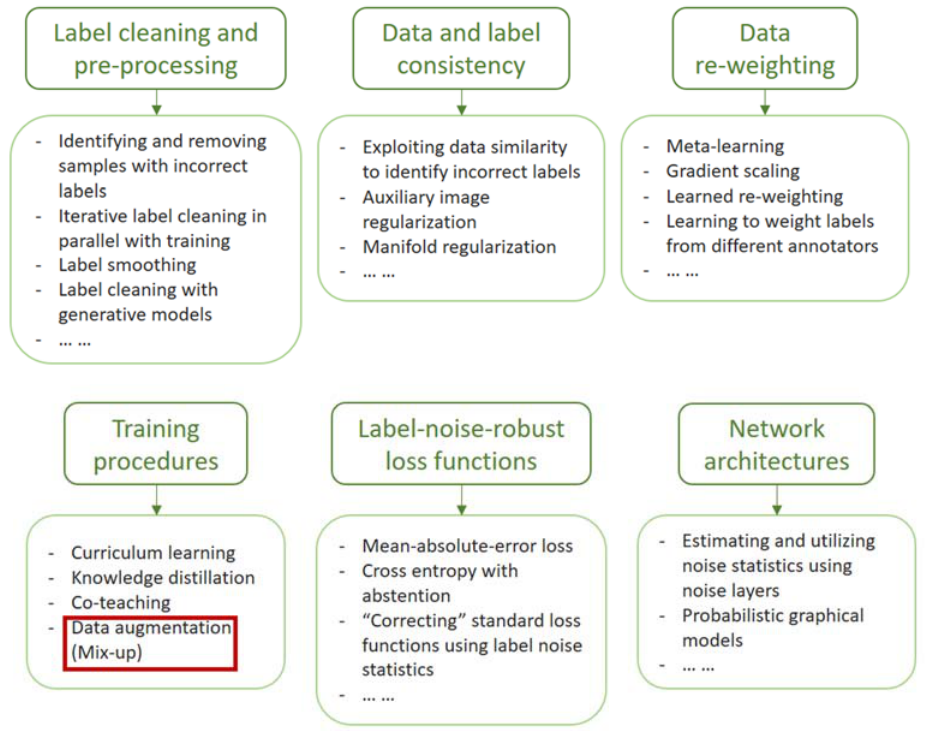
Figure 1. The overview of the state-of-the-art techniques of handling label noise in deep-learning- based approaches. The content was summarized based on Karimi et al. [39]. In this research, we chose “Data augmentation” by intermixing multi-source data to test whether the OBIA labels have potential to replace the Manual labels. The designation of experiments can be found in Section 2.5.